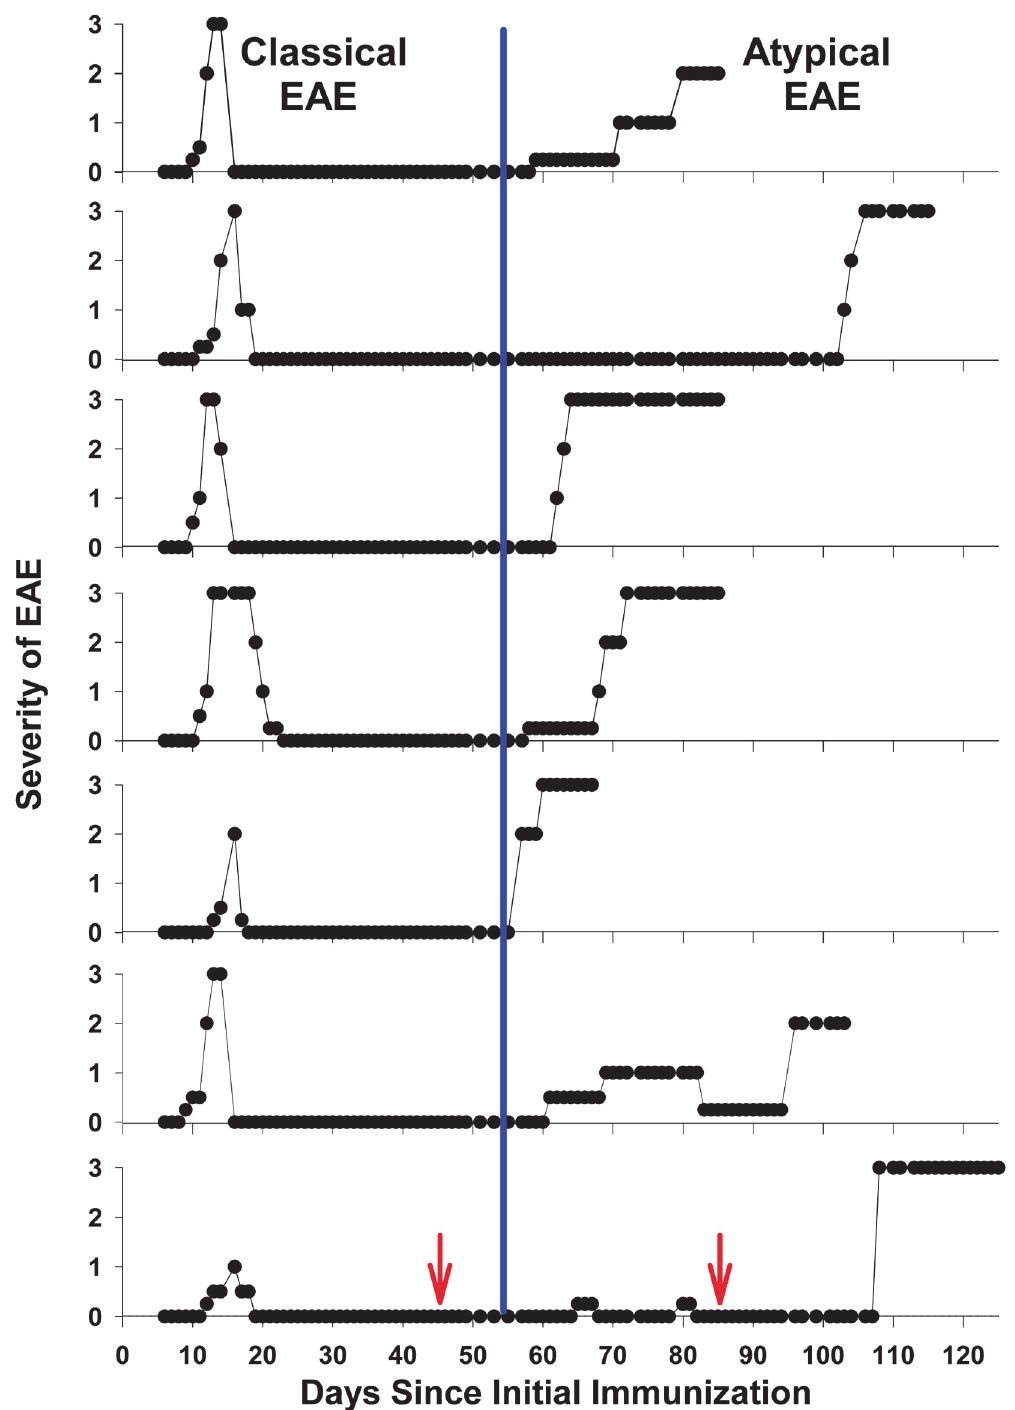
Figure 1. Booster immunizations with IgV-MOG in IFA caused a chronic course of atypical EAE. Seven Lewis rats were immunized with a mixture of 25 μ g of GP69-88 and 50 μ g of rat IgV-MOG in CFA on day 0. After resolution of a classical monophasic bout of EAE, the same rats were boosted with 200 μ g of rat IgV-MOG in IFA on days 45 and 85. Rats were scored daily for clinical signs of EAE. After the IgV-MOG boosts in IFA, the incidence of chronic atypical EAE was 100% (7 of 7 rats). The red arrows (bottom panel) mark the dates of the boosts. Shown are the individual disease courses for the 7 rats. The blue line divides the clinical data into classical (left) and atypical (right) EAE